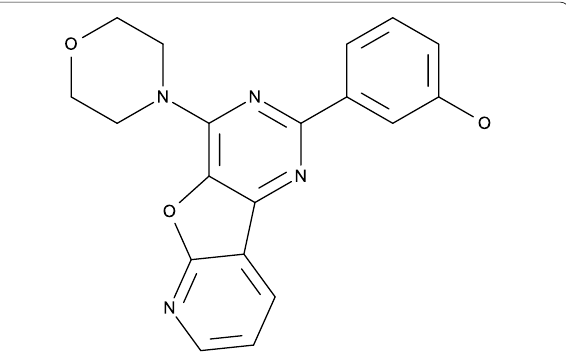
Fig. 2 2D structure of the reference ligand 3-(4-morpholin-4-ylpyr ido[3 ′ ,2 ′ :4,5]furo[3,2-d]pyrimidin-2-yl)phenol (X6K) . 2D